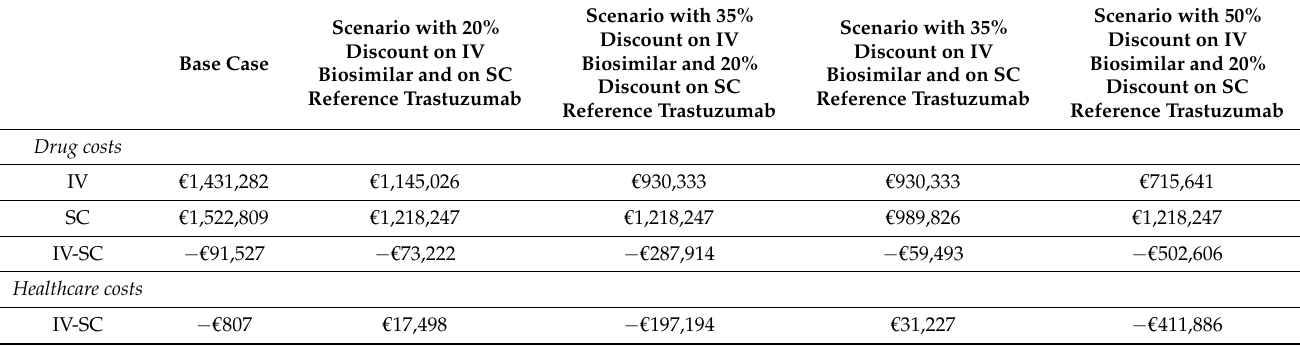
Table 1. Drug costs and healthcare costs of treating 100 patients with IV biosimilar trastuzumab vs. SC reference trastuzumab. Base